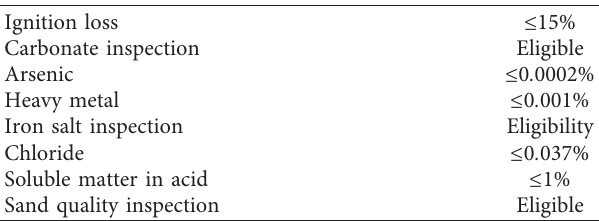
Table 3: Technical conditions of ceramic clay.